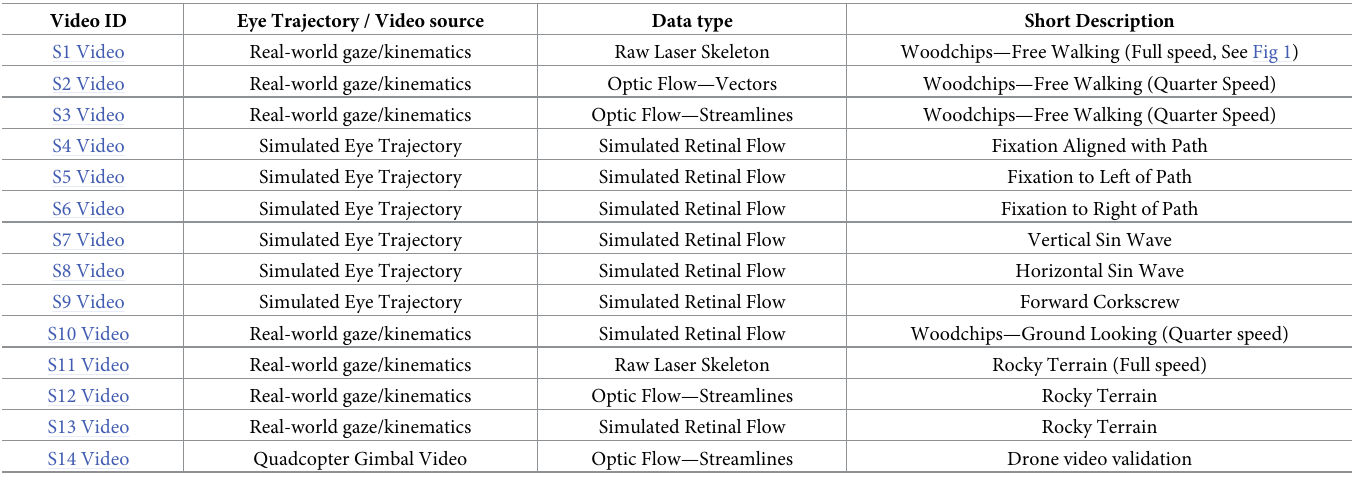
Table 1. List of videos in this